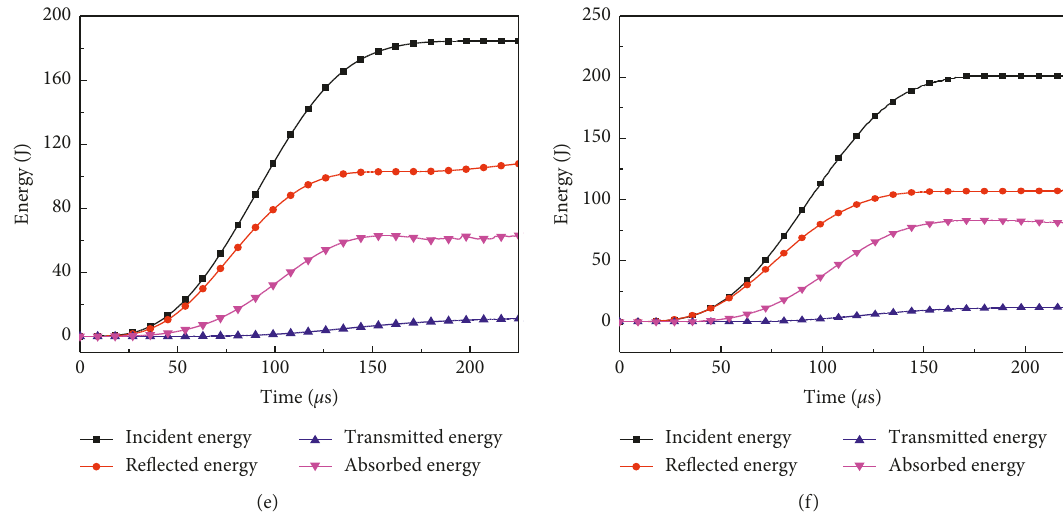
Figure 8: Energy-time curves of samples under impact loading. (a) US-1. (b) US-2. (c) US-3. (d) US-4. (e) US-5. (f)